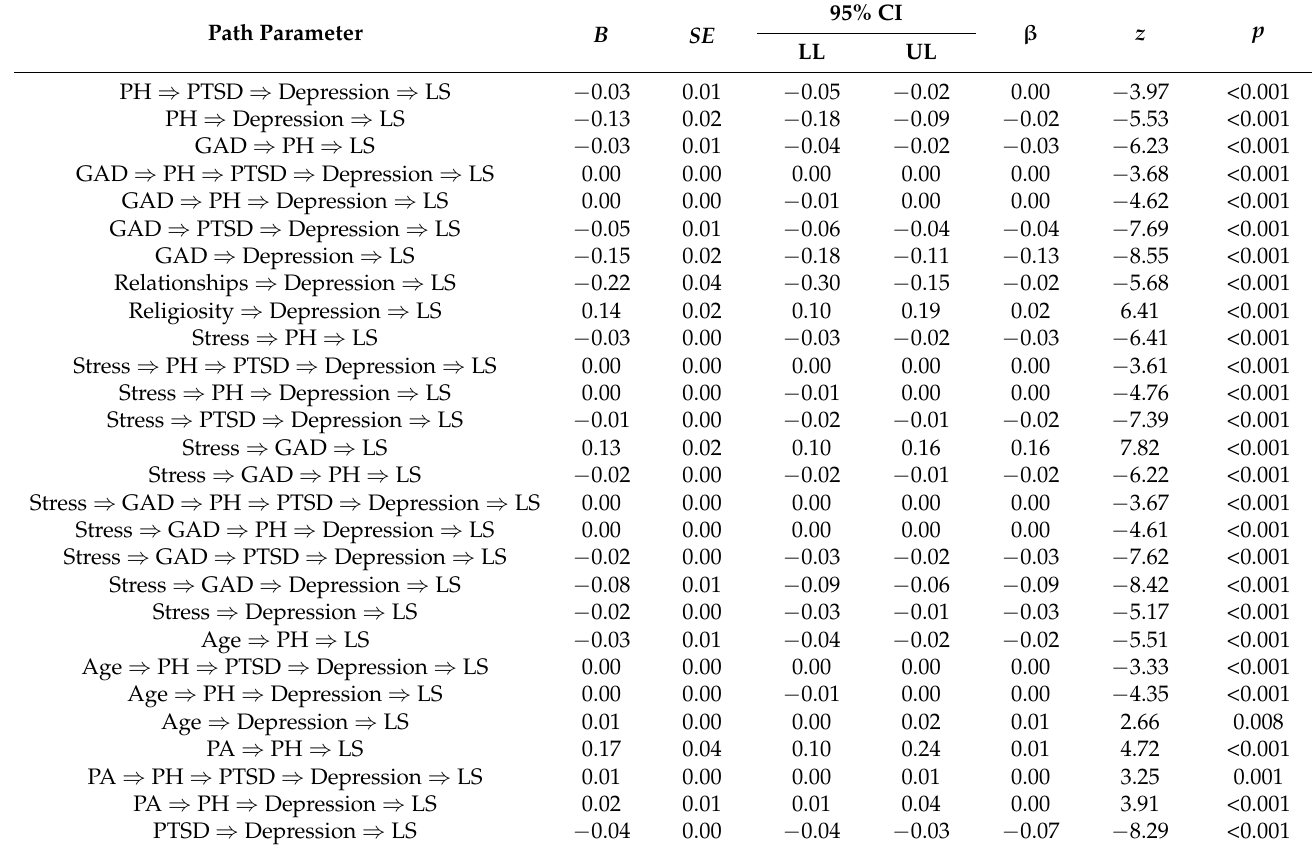
Table 8. Estimation of path parameters for life satisfaction ( N =